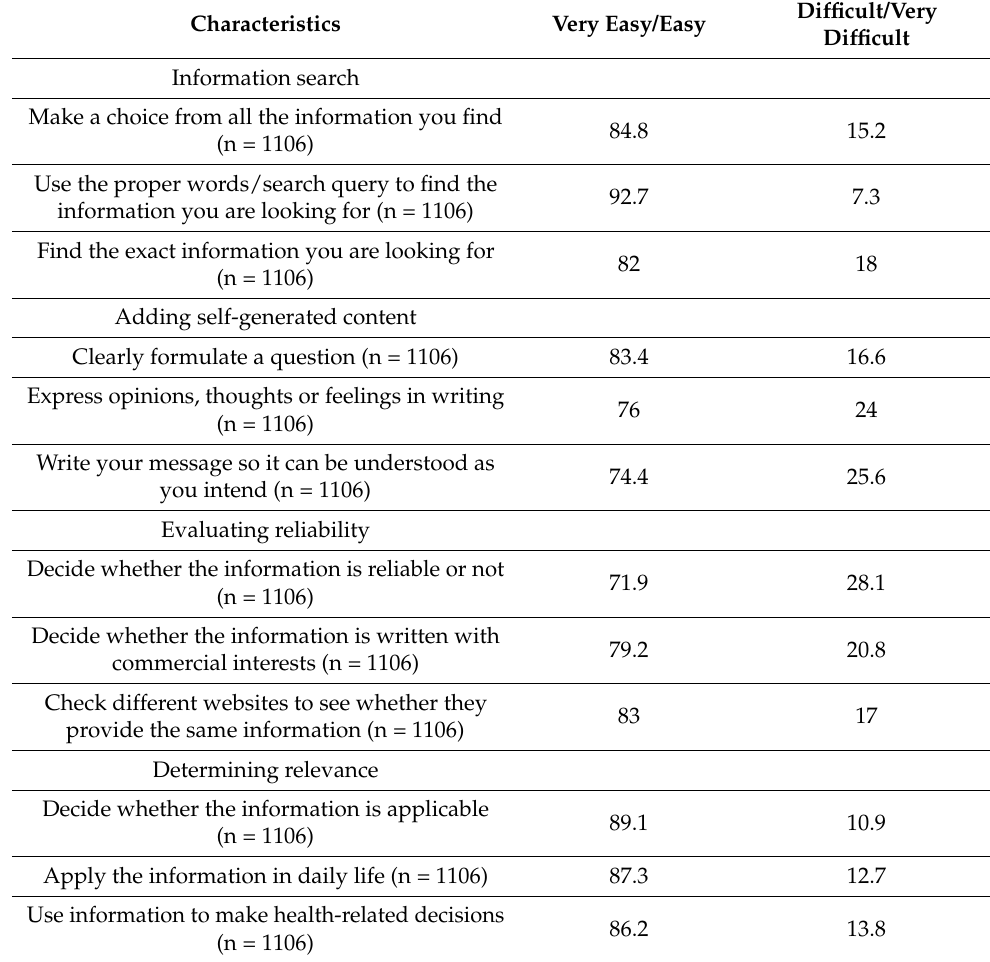
Table 3. Digital health literacy for each subscale among respondents. N = 1106. Pct.